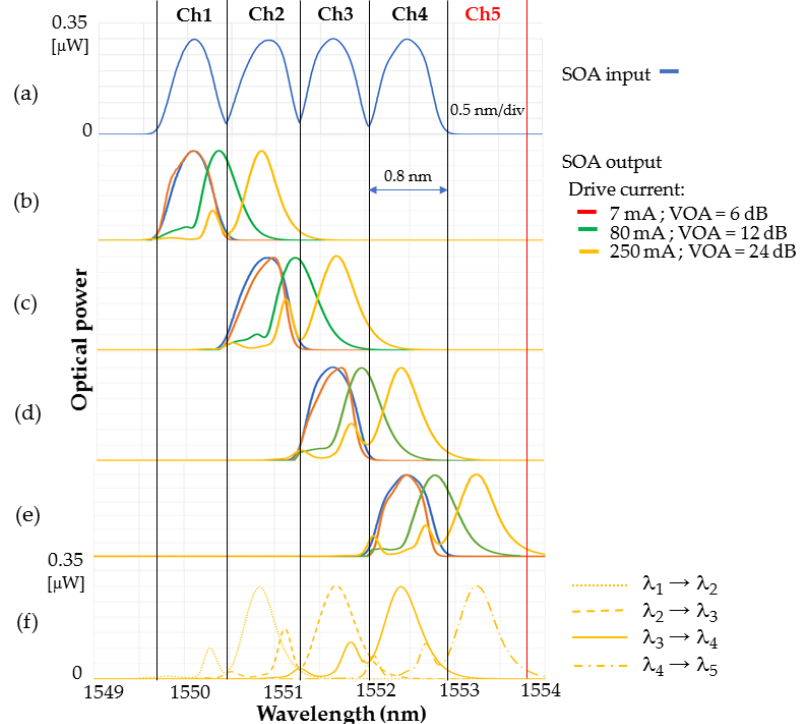
Figure 4. Experimental demonstration of code carriers’ wavelength redshift observed on the optical spectrum analyser: ( a ) code carriers at the input of the SOA; ( b ) e ff ect of SOA on code carrier λ 1 at an SOA current of 7 mA / 6dB gain, 80 mA / 12 dB gain, and 250 mA / 24 dB gain, respectively; ( c ) similarly for λ 2 ; ( d ) for λ 3 ; ( e ) for λ 4 ; ( f ) illustration of redshift on all four wavelength code carriers for an SOA current of 250 mA / 24 dB